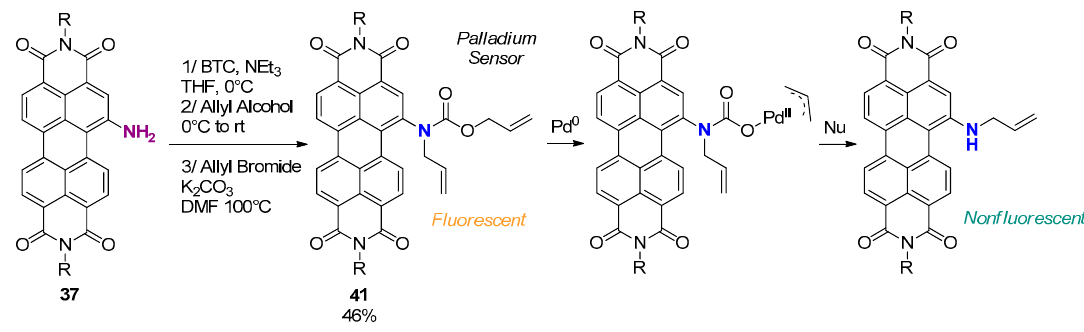
Scheme 11. Preparation of a colorimetric and fluorescent Pd 0 probe. R =